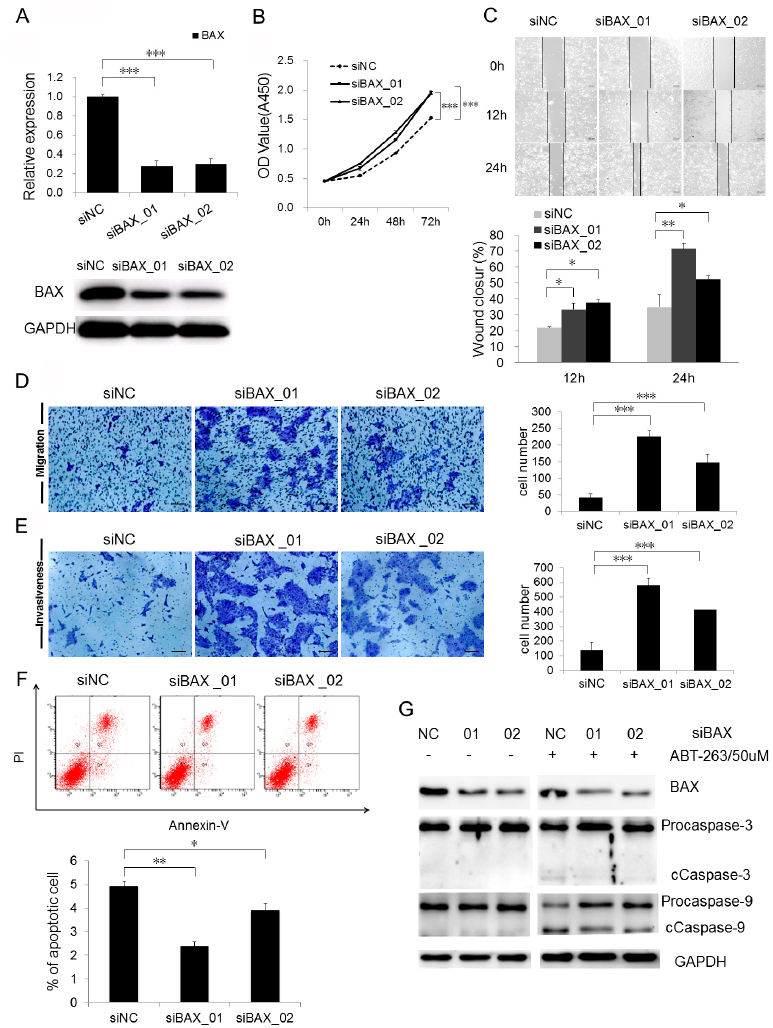
Figure 3. Loss of BAX promotes CSCC cell proliferation, migration, and invasiveness, but